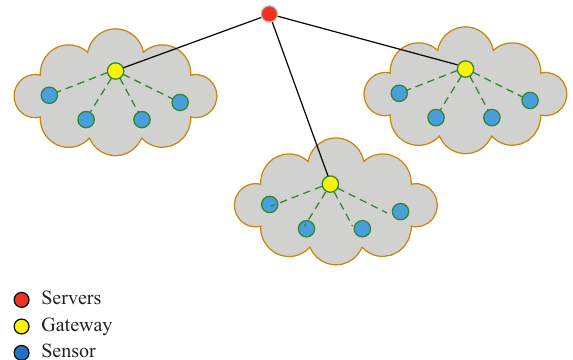
Figure 3: Network topology of sensor